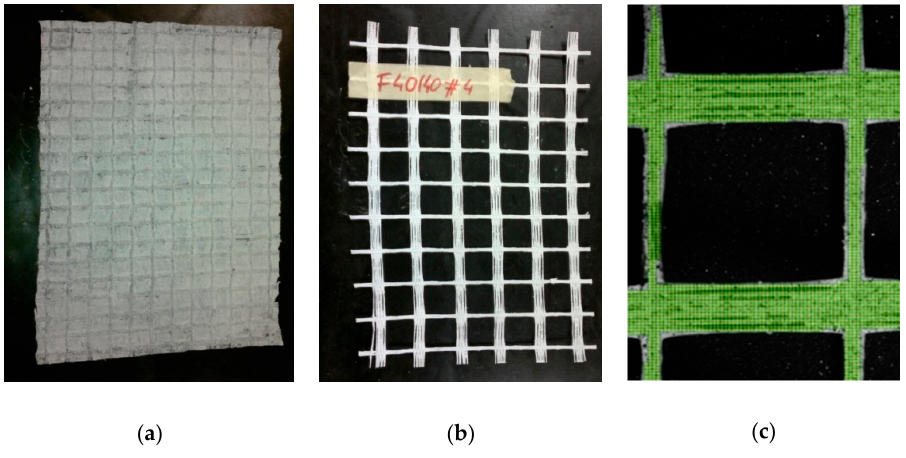
Figure 18. Geogrids samples prepared for testing: ( a ) Glass fibre geogrid; ( b ) polyester geogrid; ( c ) virtual grid for the polyester geogrid (geosynthetics) [52]. Table 3. Linear vertical strains (cross machine direction)—glass fibre geogrid; average values of strains from 5 samples [52].